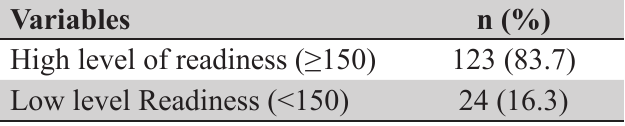
Table 2. Participant’s Level of Readiness in Self Directed Learning (N=147).